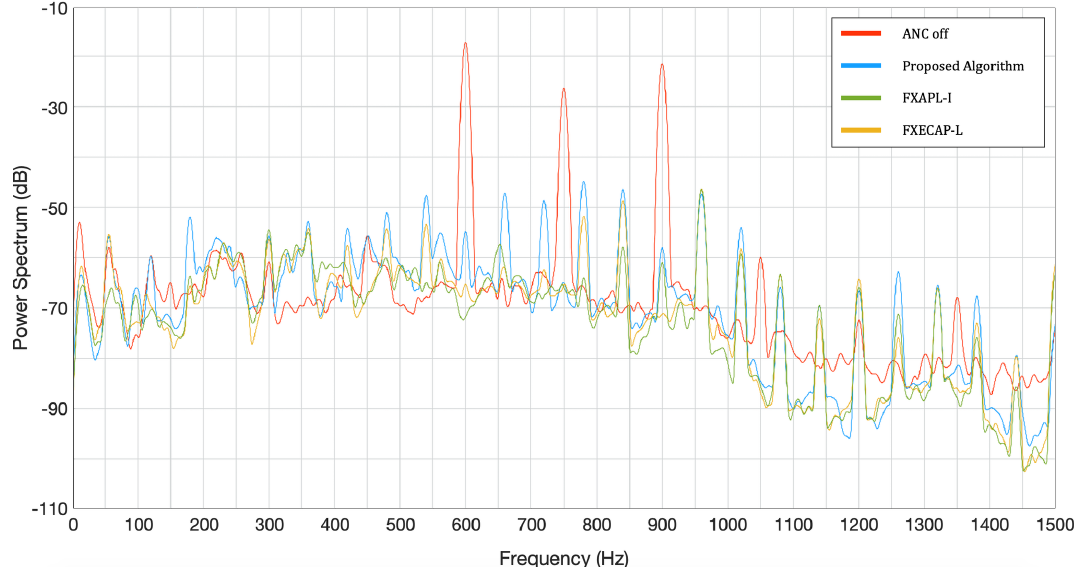
Figure 9. Power spectrum of the error signal at microphone (#1) considering a multi-tone as a reference signal.